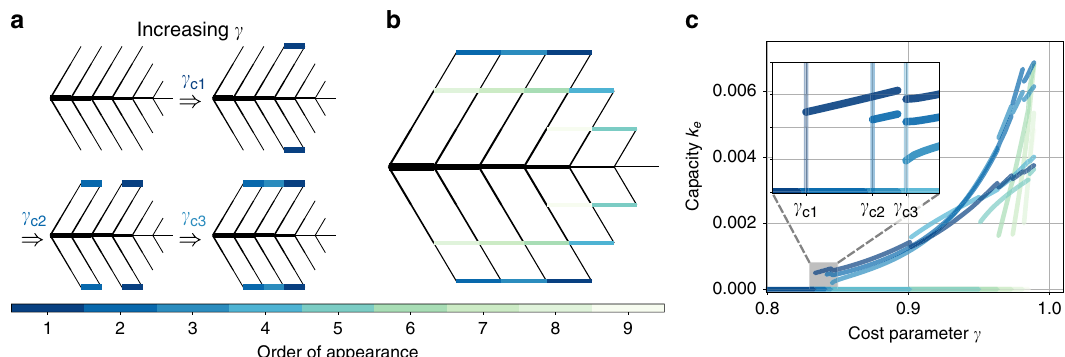
Fig. 4 Discontinuous transition to loop formation persists beyond the fi rst loop. a , b We order the loops in a colour code according to their appearance with increasing cost parameter γ : the darker the edge colour, the earlier the edge appears. For the loop that appears as the i -th loop, we denote its critical cost parameter γ ci where the loop starts to become bene fi cial for the dissipation-optimised network. c The transition to loop formation is discontinuous beyond the fi rst loop: loops appearing at higher values of γ again appear with a non-zero capacity as shown in detail in the inset. Fluctuation strength is fi xed to σ = 0.5 for all